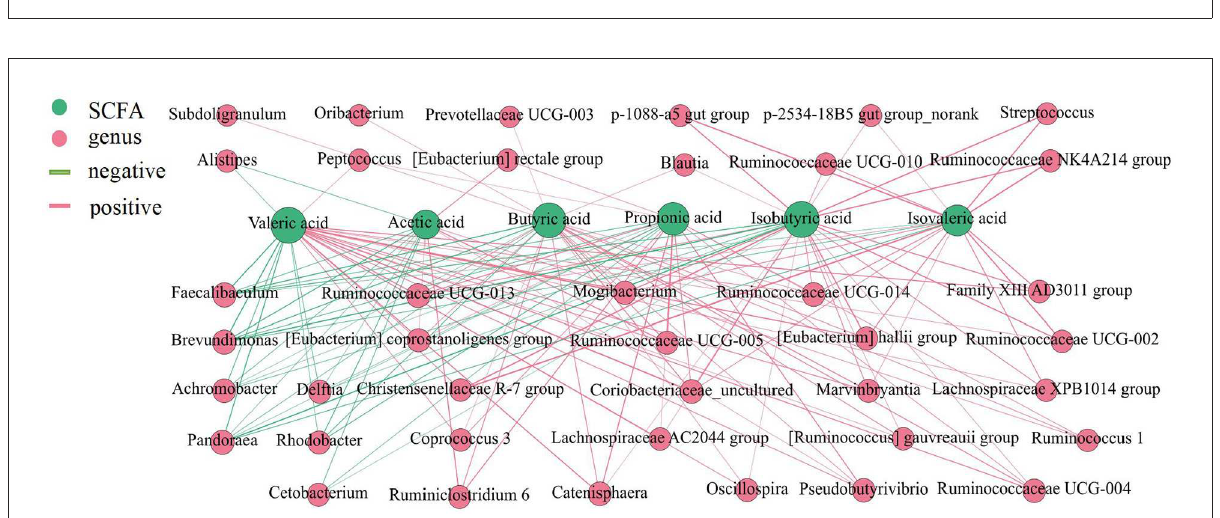
FIGURE6 Correlation analysis between the microbial community and the concentrations of SCFAs in the intestine of pigs. The association between the top 100 genera and SCFAs were analyzed using Spearman’s correlation method. The node size is proportional to the number of connections.